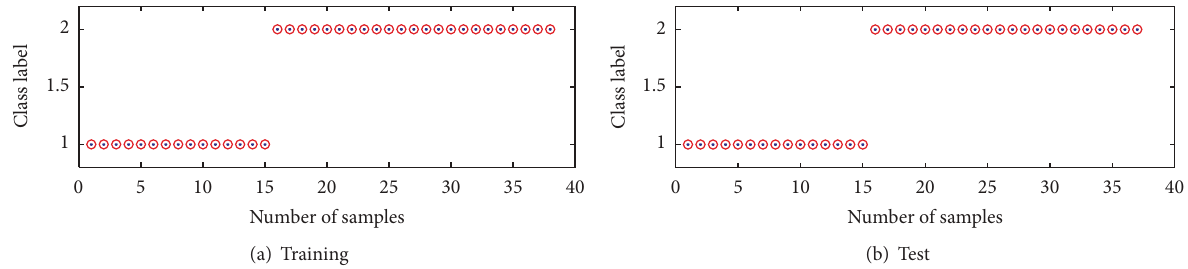
Figure 7: Identification performance of the PLS-DA classifier.